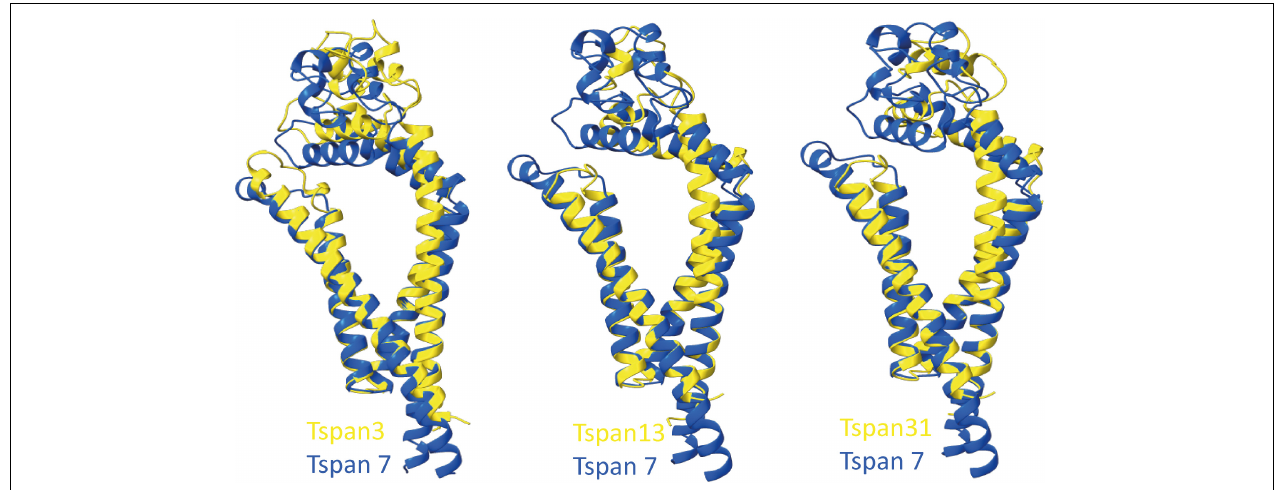
FIGURE 9 | Superimposition of AlphaFold-predicted structures of Tspan3, Tspan13, and Tspan31 with Tspan7 using ChimeraX. Aligned structures of Tspan3, Tspan13, and Tspan31 (yellow) and Tspan7 (blue). RMSD values for Tspan3/7, Tspan13/7, and Tspan31/7 are 0.9, 0.829, and 0.854 Å, respectively.